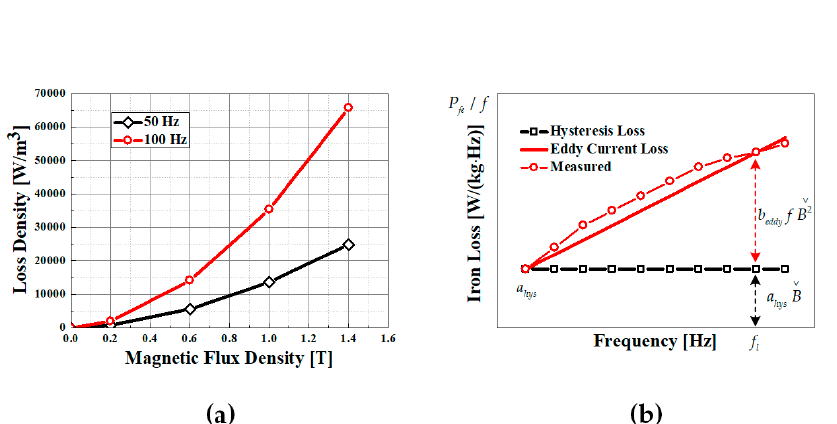
Figure 4. ( a ) Measured iron loss data at 50 kHz and 100 kHz from silicon steel 50PN470. ( b ) The estimated hysteresis loss factor from two frequencies of iron loss data. Figure 5a,b show a photograph of a prototype sample and the magnetic flux density distribution in a 2D plane. Figure 5c,d show the magnetic flux density of point A in the time frame and FFT analysis.